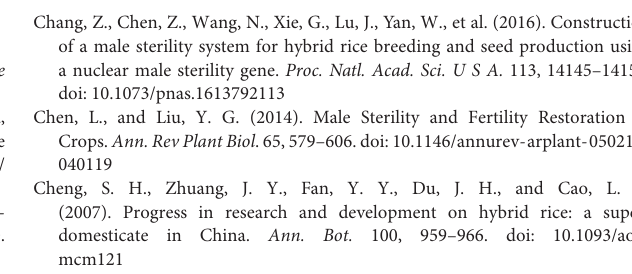
Supplementary Table 9 | The predicted lncRNAs function as miRNA precursors in